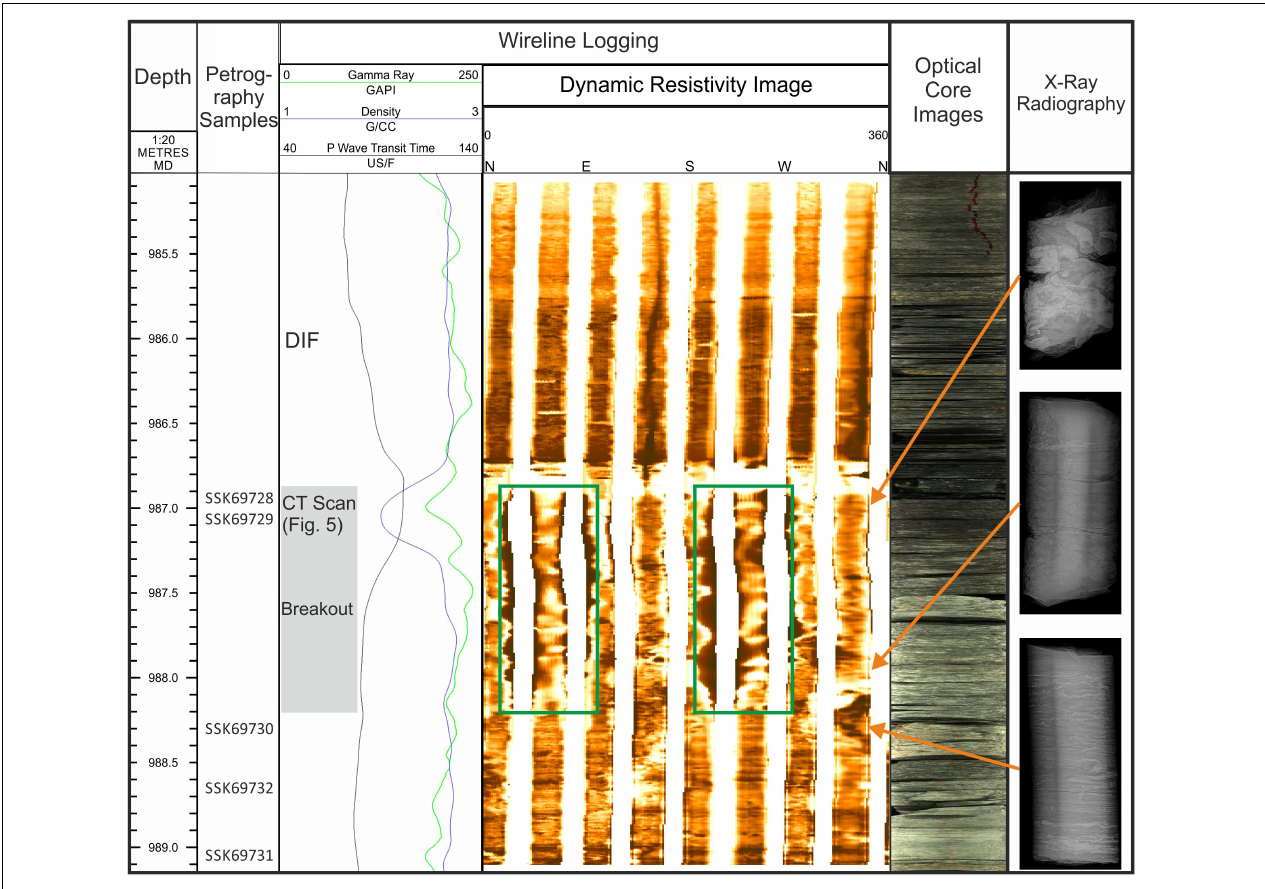
FIGURE 5 | Borehole imaging and X-ray radiography across the breakout zone in the Melbourne 1 borehole: Left panel, Sample track showing location of Petrography samples ( Table 2 ). Center Left panel, conventional wireline logs including Sonic Transit Time and Gamma Ray, Depth of CT scan in Figure 6 marked, breakout shown in gray. Center Panel, Unwrapped CMI resistivity image (clockwise from North) and breakouts highlighted by green boxes. Center Right Panel, Optical line scan images of the core from the MSCL-S. Right Panel, X-ray radiography from three palaeosol samples taken independently of the petrography, showing increased disruption of sedimentary structures toward the